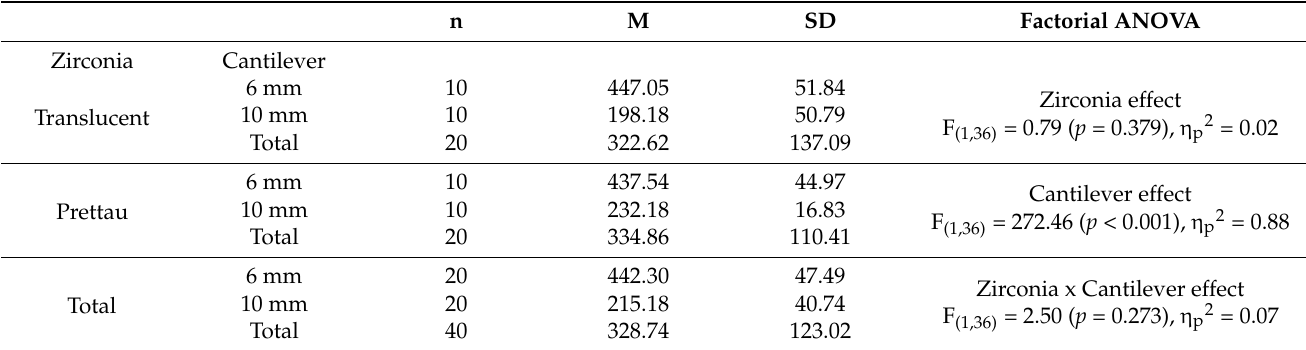
Table 4. Factorial ANOVA for the effect of type of zirconia and cantilever length on force at break (standard) (N) .